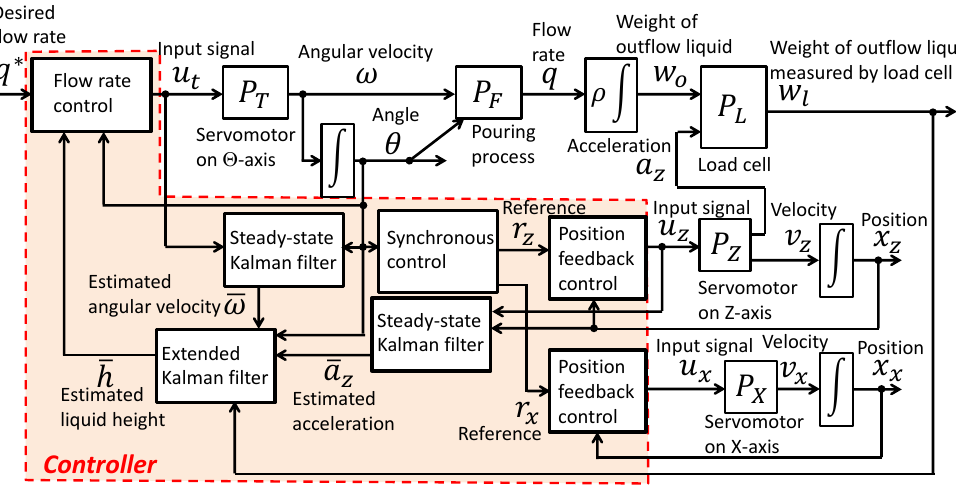
Signal diagram of the entire control system for applying flow rate control to the tilting-ladle-type automatic pouring machine.